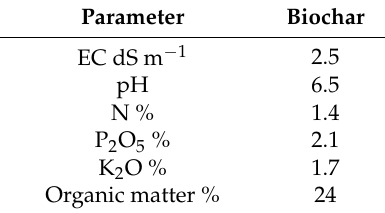
Table 4. Biochar